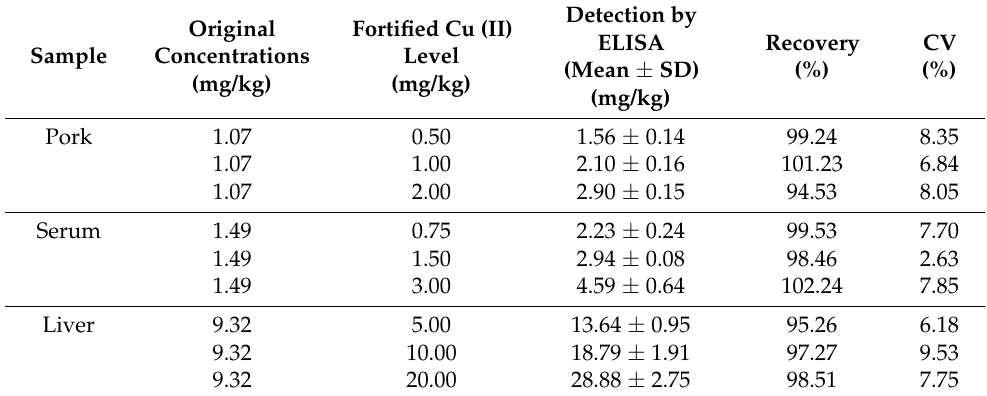
Table 2. Recovery test of Cu (II) concentration in pig samples ( n = 6).